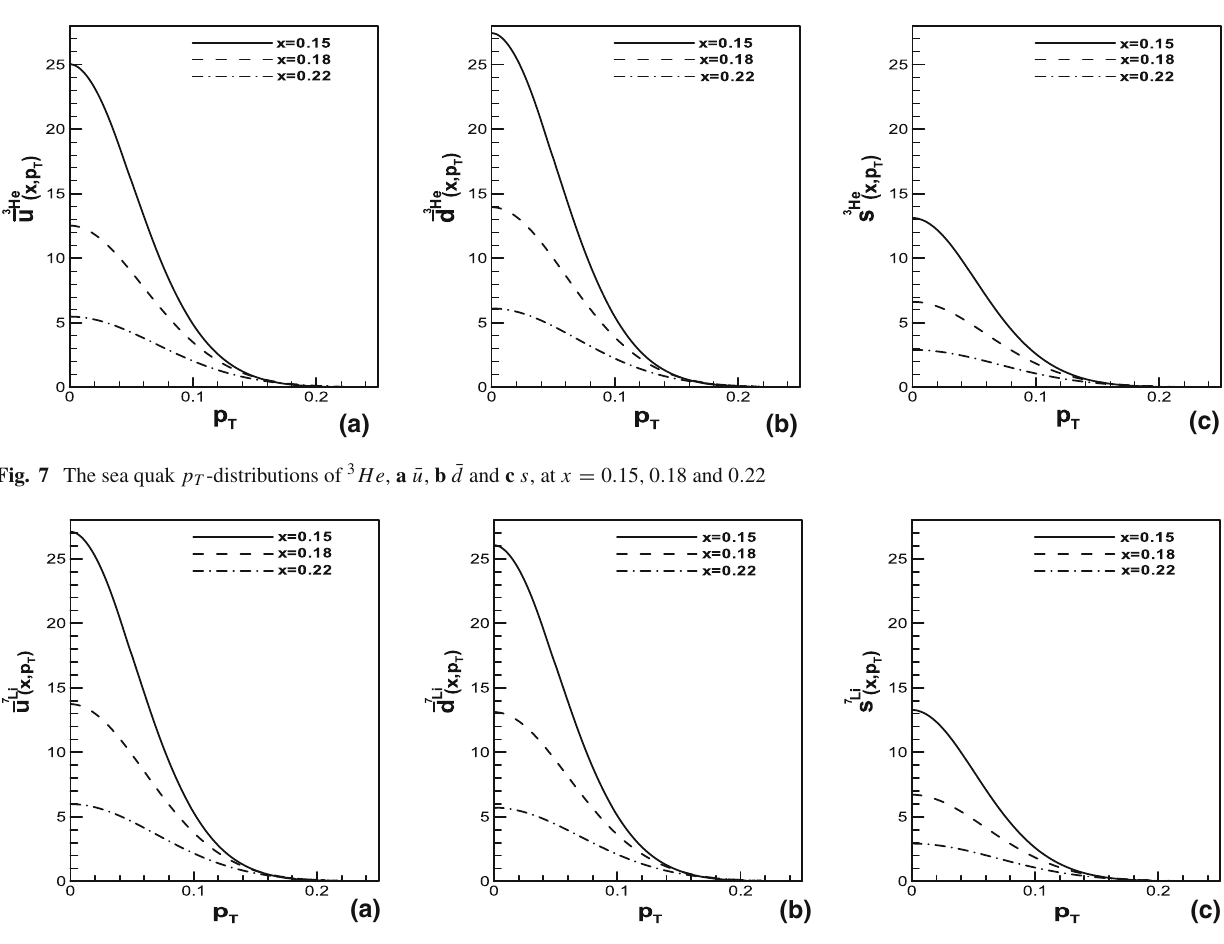
Fig. 8 The p T -distribution of a ¯ u , b ¯ d and c s at x = 0 . 15 , 0 . 18 and 0 . 22 for 7 Li